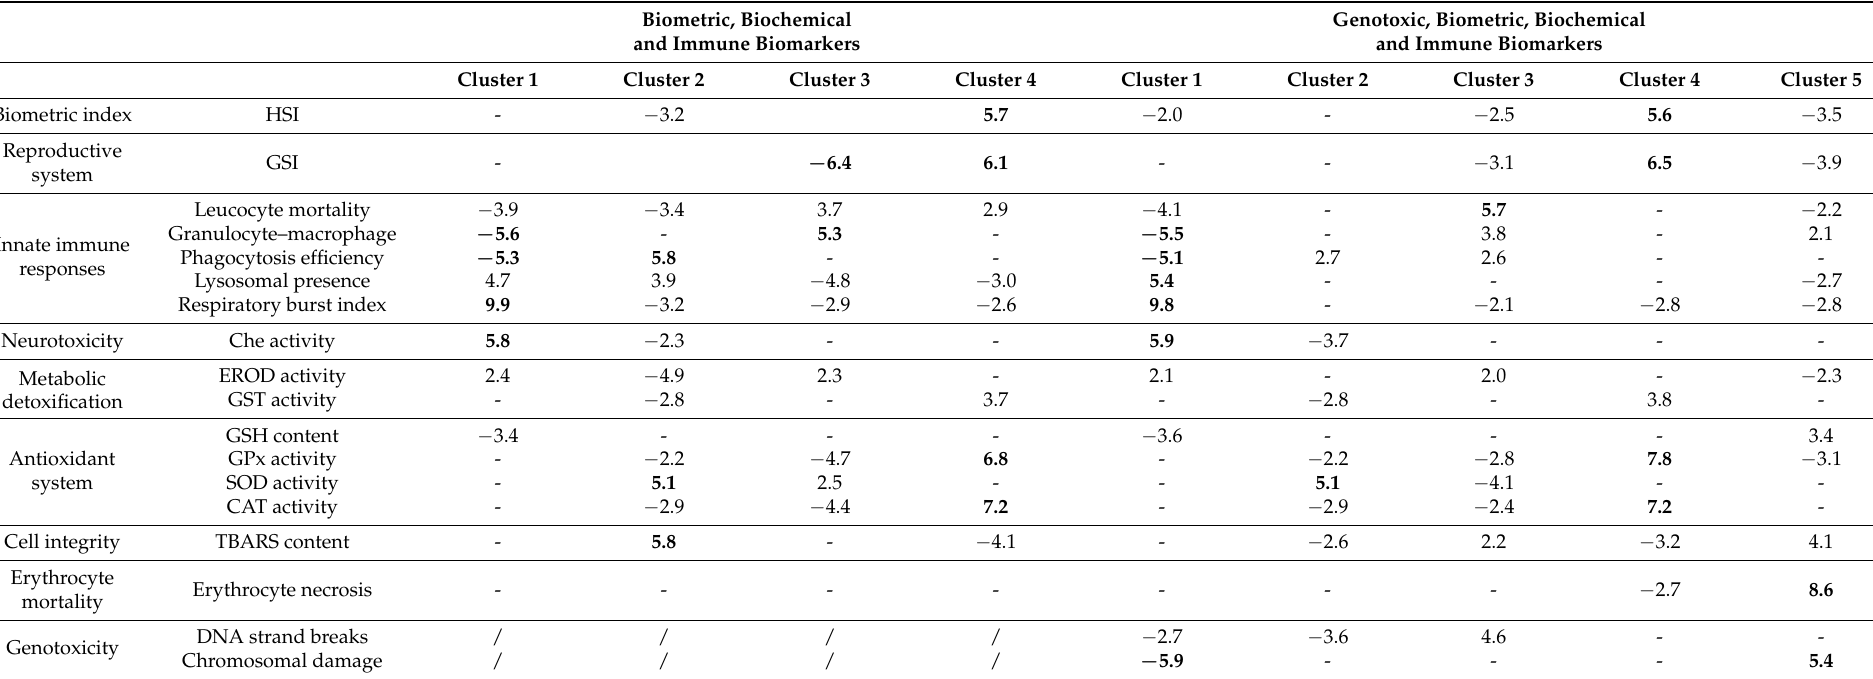
Table 4. The contribution of current biomarkers with or without integration of genotoxic biomarkers to the building of each cluster in the HAC. The results indicate only the significant v-test obtained for each biomarker and each cluster ( | v-test | ≥ 2.03, p -value ≤ 0.05). The most substantially contributing v-tests are represented in bold ( | v-test | ≥ 5.0, p -value ≤ 0.05). HSI: hepatosomatic index; GSI: gonadosomatic index; Che: cholinesterase; EROD: 7-ethoxyresorufin-O-deethylase;